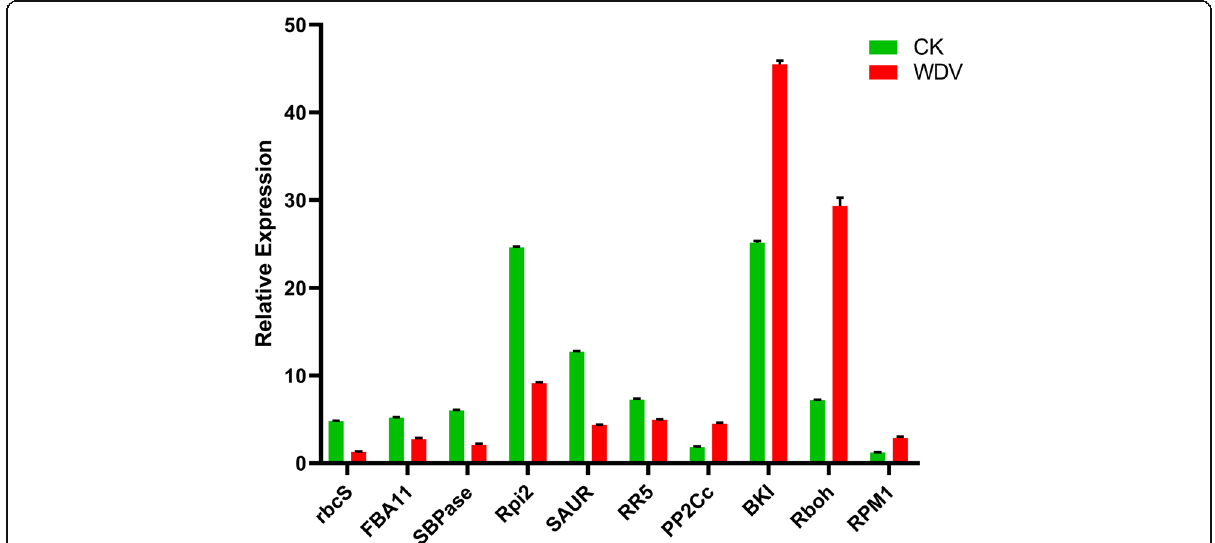
Fig. 4 Validation of transcriptome results by reverse transcription quantitative PCR (RT-qPCR). Ten genes were selected from the RNA-sequencing data for RT-qPCR. The error bars represent standard deviations of the